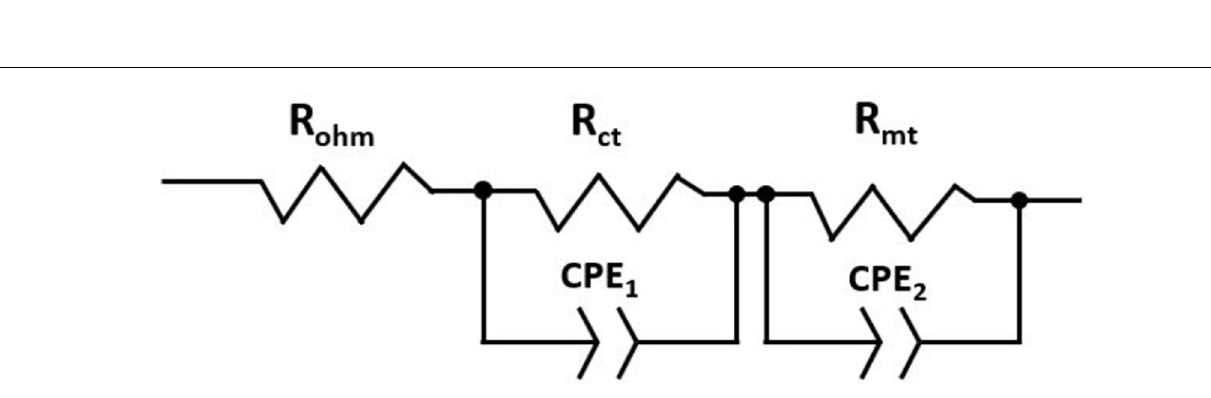
Frontiers in Energy Research |